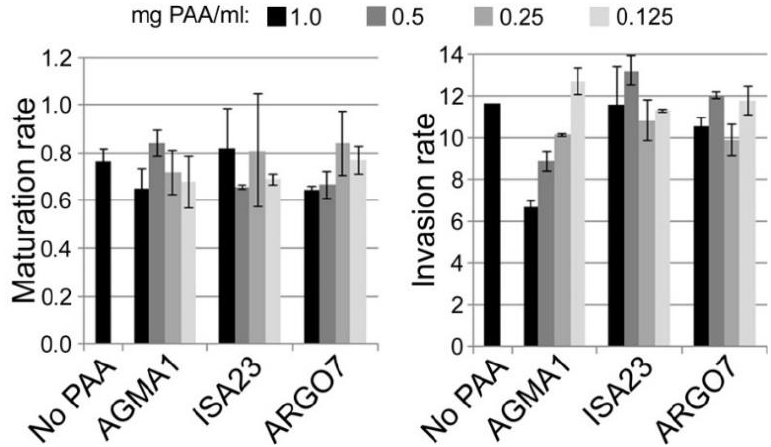
Figure 6. In vitro determination in the presence of PAAs of P. falciparum maturation and invasion rates.